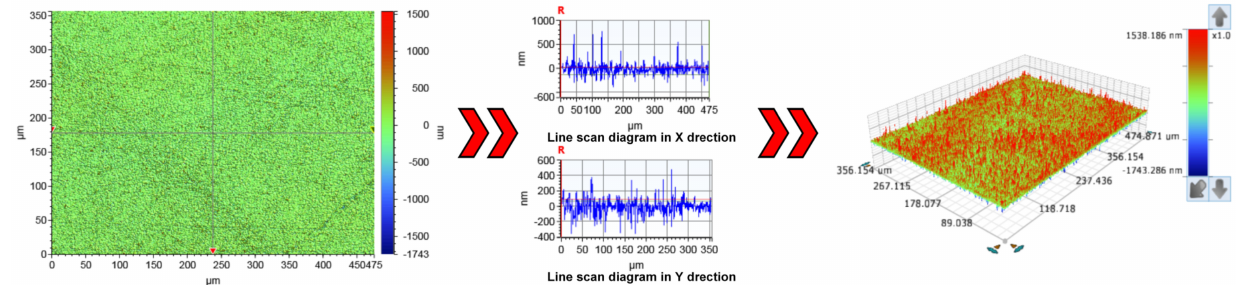
Figure 6. Surface morphology of processed quartz glass after dressing